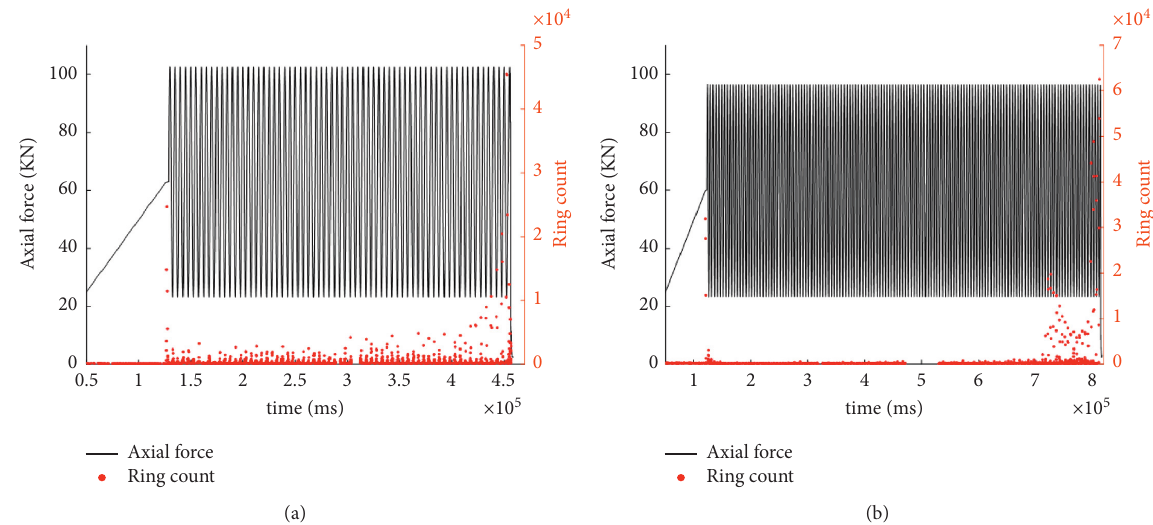
Figure 7: Evolution law of acoustic emission: (a) acoustic emission evolution law of specimen 1; (b) acoustic emission evolution law of specimen